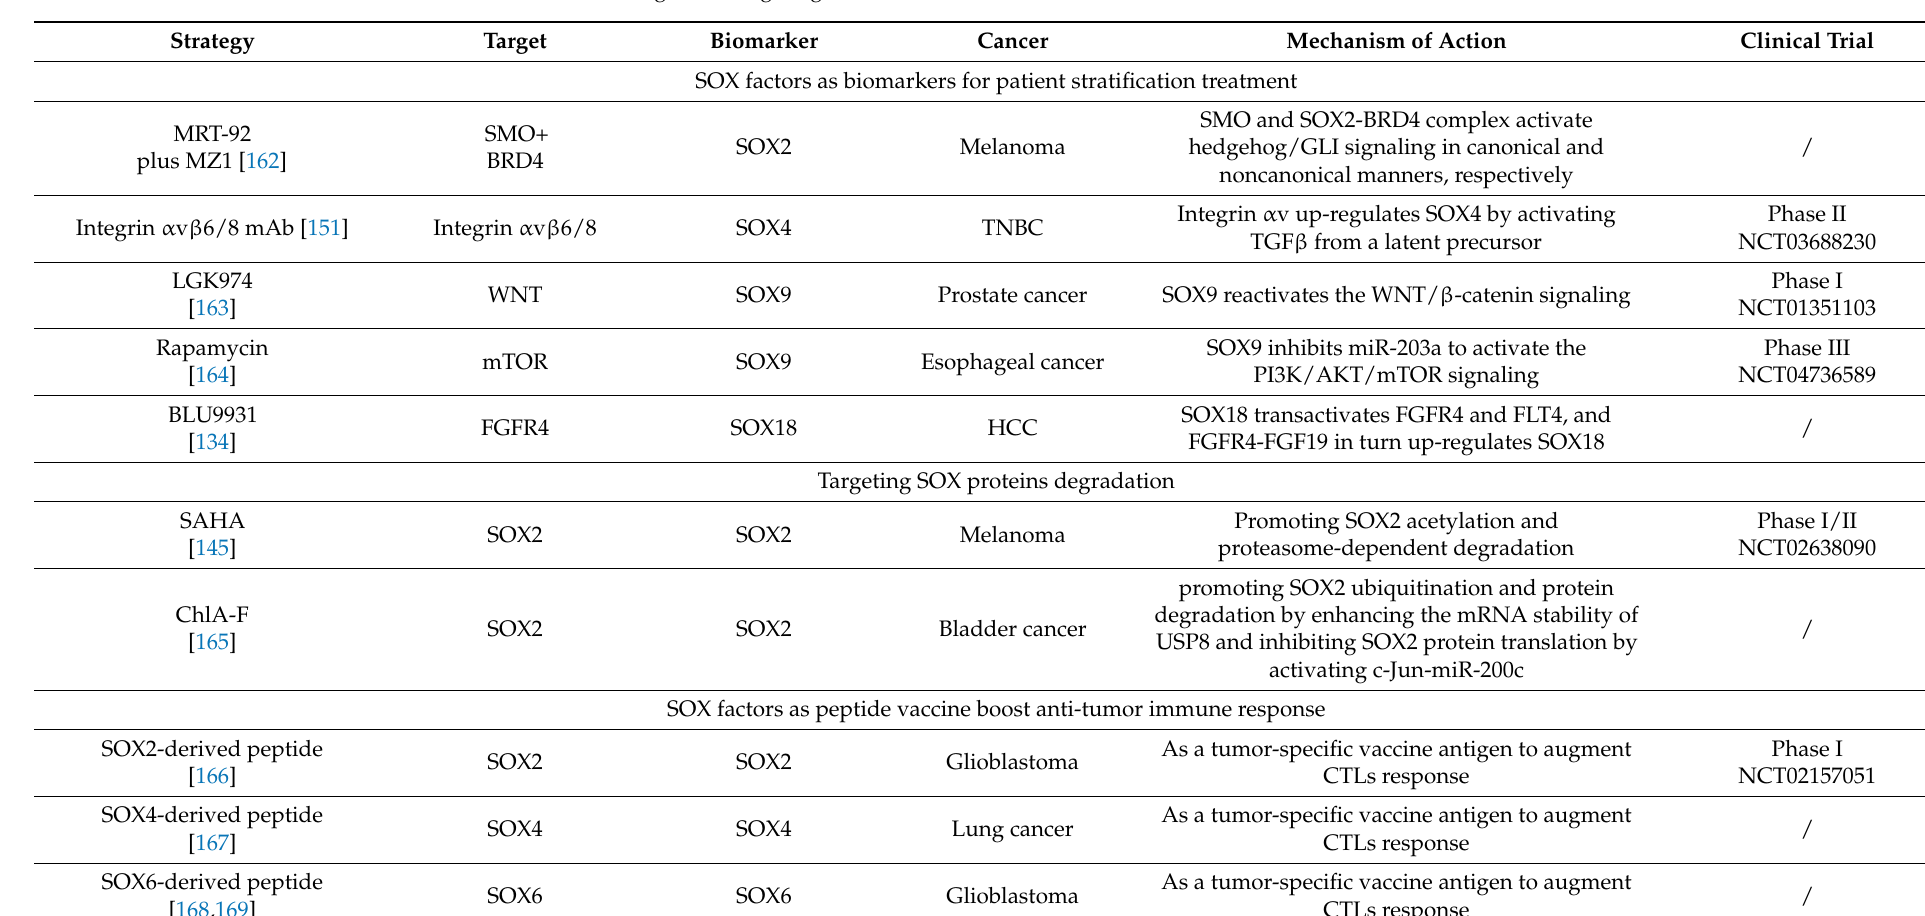
Table 1. The alternative strategies for targeting SOX factors in